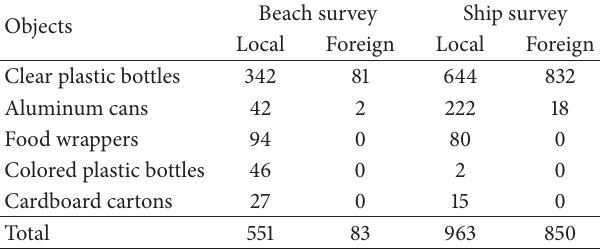
Table 9: Total objects (number, items ) according to EAN interna- tional barcodes found at beach and ship